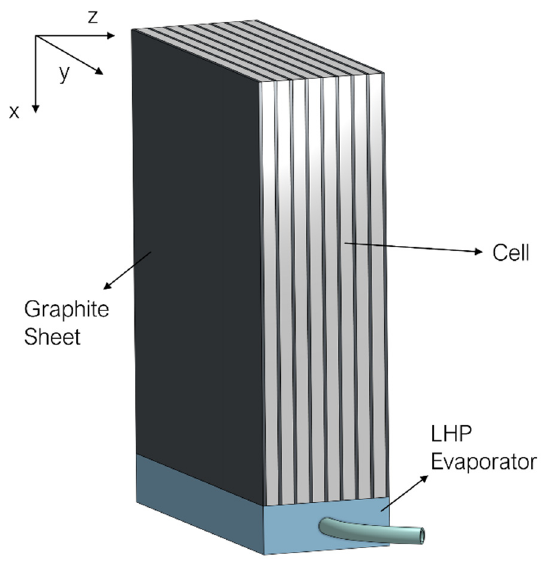
Figure 2. Loop Heat Pipe and Graphite based Thermal Management System.